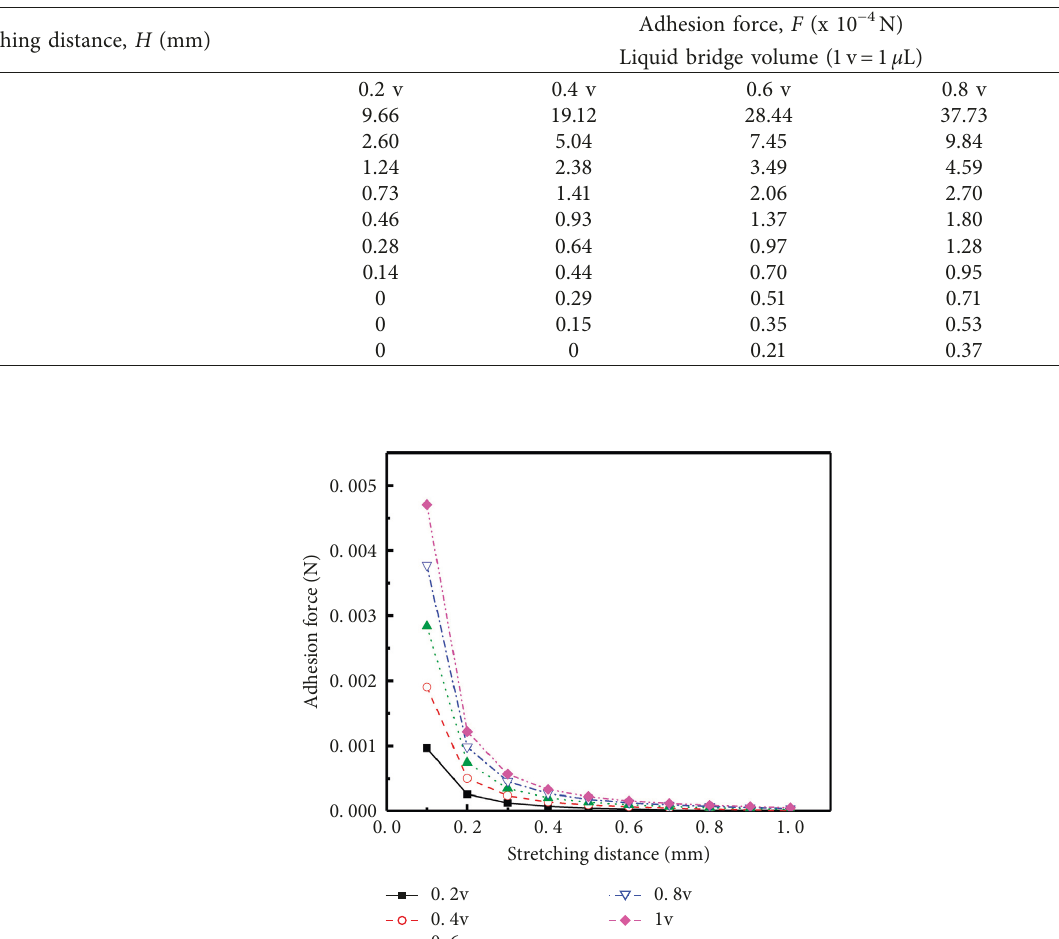
Table 2: Theoretical value of liquid bridge adhesion force under different liquid bridge volume.